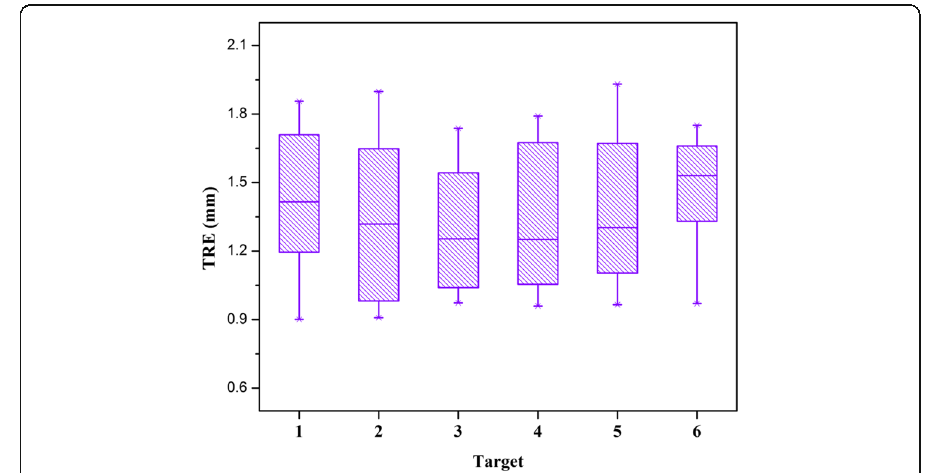
Fig. 12 TRE values achieved by performing the proposed automatic